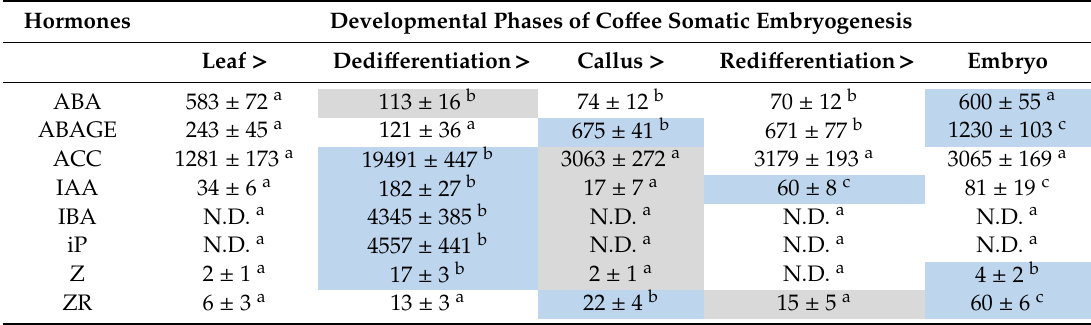
Table 4. Hormone dynamics during the five main developmental phases of the Arabica SE process. Hormones Developmental Phases of Co ff ee Somatic Embryogenesis Leaf > Dedi ff erentiation > Callus > Redi ff erentiation > Embryo ABA 583 ± 72 a 113 ± 16 b 74 ± 12 b 70 ± 12 b 600 ± 55 a ABAGE 243 ± 45 a 121 ± 36 a 675 ± 41 b 671 ± 77 b 1230 ± 103 c ACC 1281 ± 173 a 19491 ± 447 b 3063 ± 272 a 3179 ± 193 a 3065 ± 169 a IAA 34 ± 6 a 182 ± 27 b 17 ± 7 a 60 ± 8 c 81 ± 19 c IBA N.D. a 4345 ± 385 b N.D. a N.D. a N.D. a iP N.D. a 4557 ± 441 b N.D. a N.D. a N.D. a Z 2 ± 1 a 17 ± 3 b 2 ± 1 a N.D. a 4 ± 2 b ZR 6 ± 3 a 13 ± 3 a 22 ± 4 b 15 ± 5 a 60 ± 6 c Values represent the mean of hormone levels, expressed in ng / g DW, in the sampled stages forming each of the five phases (Leaf, Dedi ff erentiation, Callus, Redi ff erentiation and Embryo) in three independent replicates ± SD. For each hormone, di ff erences in levels between phases were analysed with a Kruskal-Wallis test. Data followed by di ff erent letters are significantly di ff erent according to Dunn post-hoc test ( P < 0.05). Blue color corresponds to an increase in hormone levels between a phase and the previous one (column on the left) while grey color corresponds to a decrease in hormone levels. N.D. stands for not detected. ABA: cis -abscisic acid, ABAGE: ABA glucose ester, IAA: indole-3-acetic acid, IBA: indole 3-butyric acid, iP: isopentenyladenine, Z: zeatin ( cis - and trans -), ZR: zeatin riboside ( cis - and trans